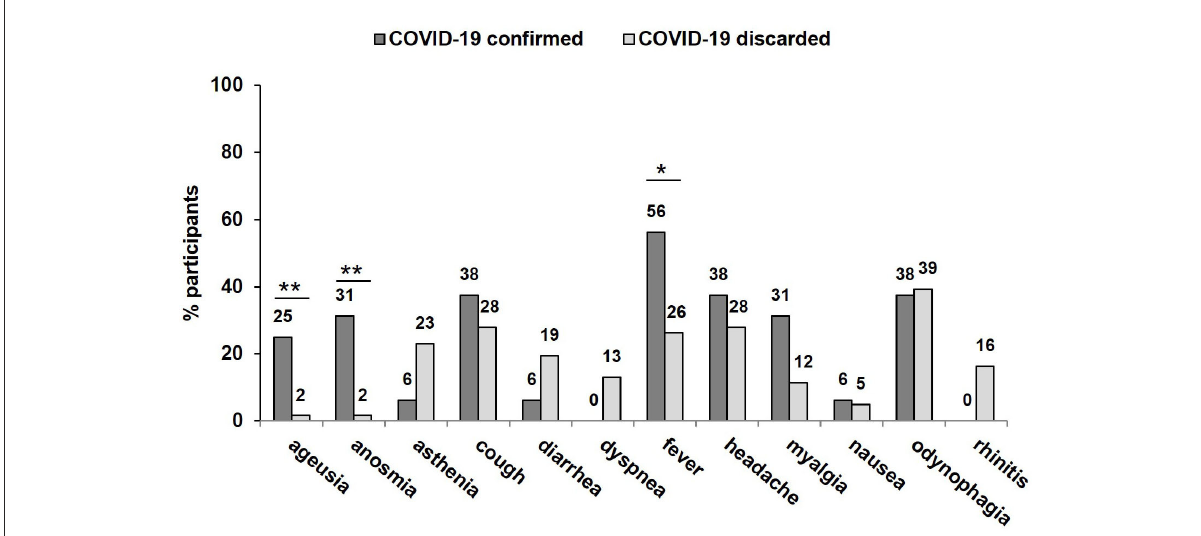
FIGURE1 Proportions of different symptoms as reported at the day of testing for SARS-CoV-2-infection stratified for the presence of COVID-19. * p < 0.05; ** p < 0.01.